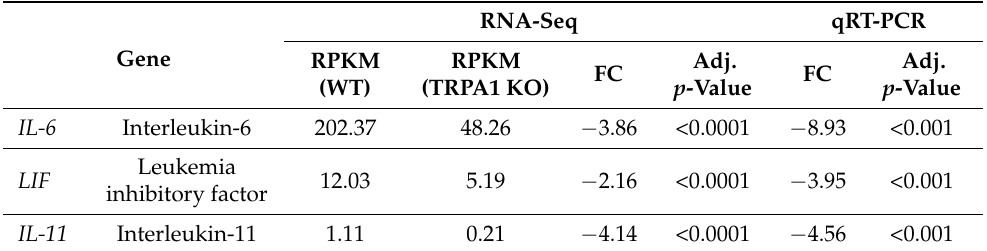
Table 1. IL-6 cytokine family members showing attenuated expression in chondrocytes obtained from transient receptor potential ankyrin 1 (TRPA1) deficient (KO) mice compared to chondrocytes from corresponding wild-type (WT) mice.